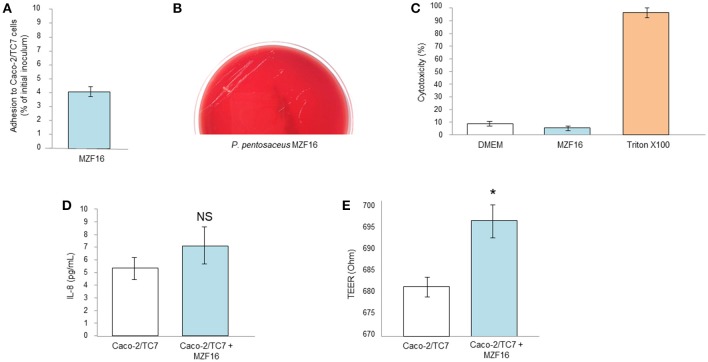
Interactions of P. pentosaceus MZF16 with eukaryotic cells. (A) Adhesion to Caco-2/TC7 cells, (B) Haemolytic activity, (C) Cytotoxicity toward Caco-2/TC7 cells, (D) Secretion of IL-8 by Caco-2/TC7 cells after exposition to MZF16, (E) TEER of Caco-2/TC7 cells exposed to MZF16. NS, not significant, *P < 0.05.